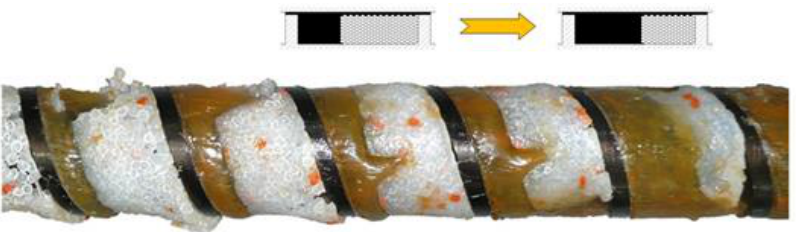
Figure 1. Classical melting mechanism of polymers in the single-screw extruder on an example of extrusion of polypropylene (PP). Reprinted with permission from [29]. Copyright Wiley 2012.